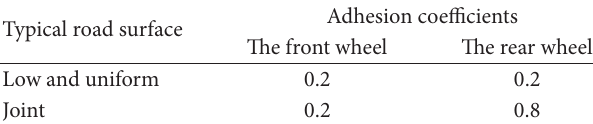
Table 2: The road surfaces. Typical road